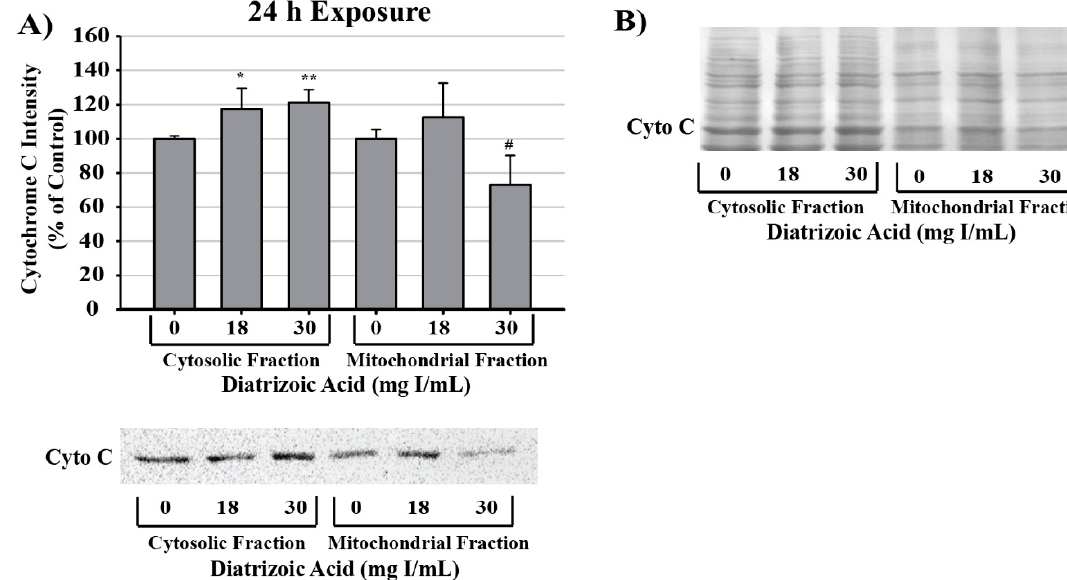
Figure 16. Diatrizoic acid effects on mitochondrial membrane integrity in HK-2 cells. DA diminished mitochondrial membrane integrity. Representative blot and cumulative densitometry for cytochrome c expression ( A ) in cytosolic and mitochondrial fractions following 24 h exposure to DA. Representative blot of protein staining to confirm equal 40 µg protein loading for cytochrome c ( B ). Asterisks (* p < 0.05, ** p < 0.01) indicate statistical difference from vehicle control in cytosolic fraction. Octothorpe (# p < 0.05) indicate statistical difference from vehicle control in mitochondrial fraction. Values represent mean ± SEM for three independent experiments.